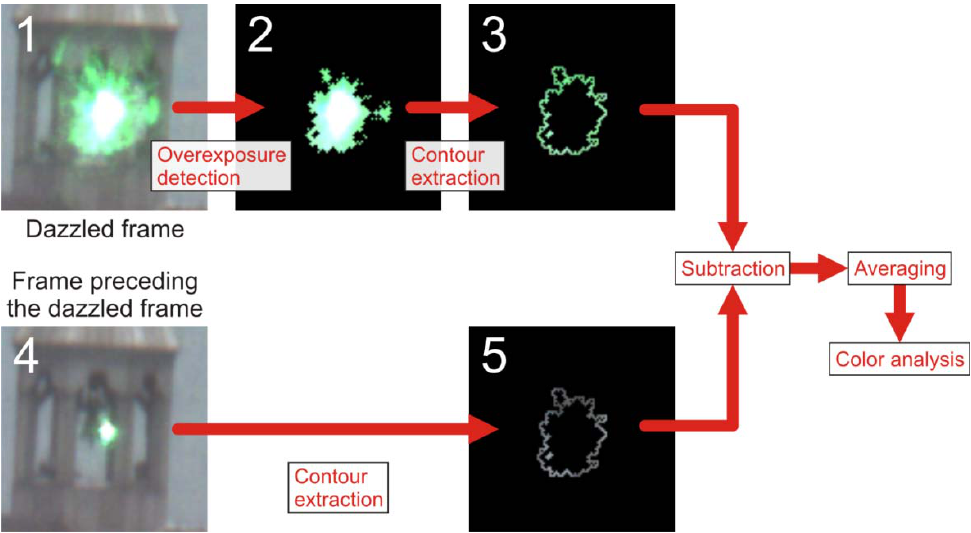
Figure 9. Flowchart of the image analysis procedure for the estimation of the dazzling wavelength. First, the overexposed pixels (see Image 2) of a dazzled frame (see Image 1) are determined. The colour of the contour line (see Image 3) is ready to be analysed after the subtraction of the background (see Image 5). The frame preceding a dazzled frame (see Image 4) is used to determine the background